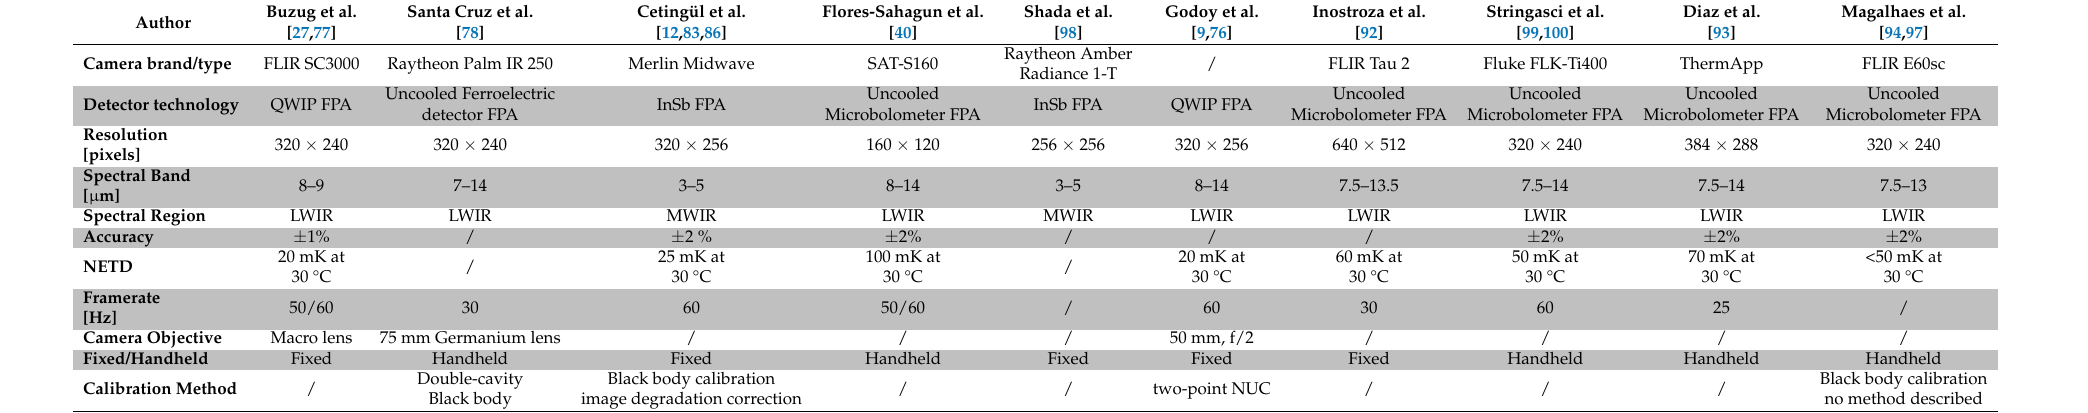
Table A3. Infrared Cameras used in previous